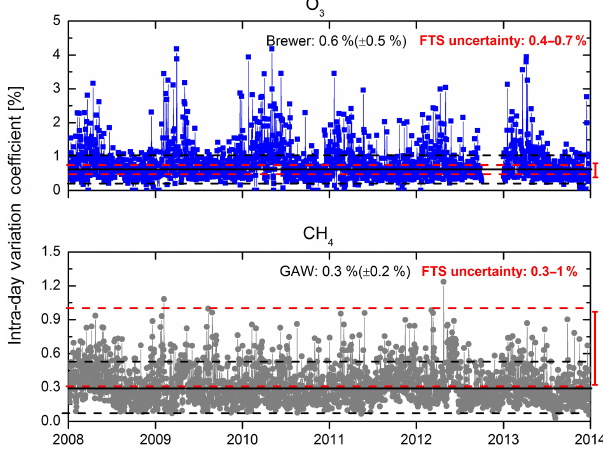
Figure B1. Intra-day variation coefficient (VC) for O 3 total column and in situ CH 4 (in %]) as observed by a Brewer spectrometer and a GAW in situ GC-FID analyzer respectively between 2008 and 2013. The solid and dashed black lines represent the median and ± 1 σ of the reference intra-day VC respectively, and the dashed red lines represent the range of theoretical and experimental FTS